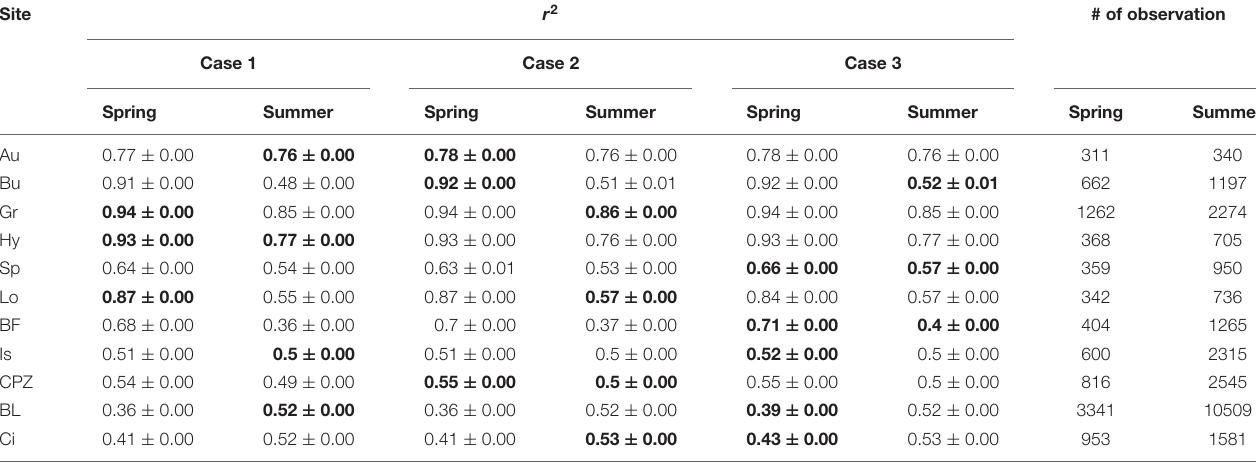
TABLE 3 | Mean r 2 ± standard deviation of the 100 ANN simulations trained with Spring and Summer data. Site r 2